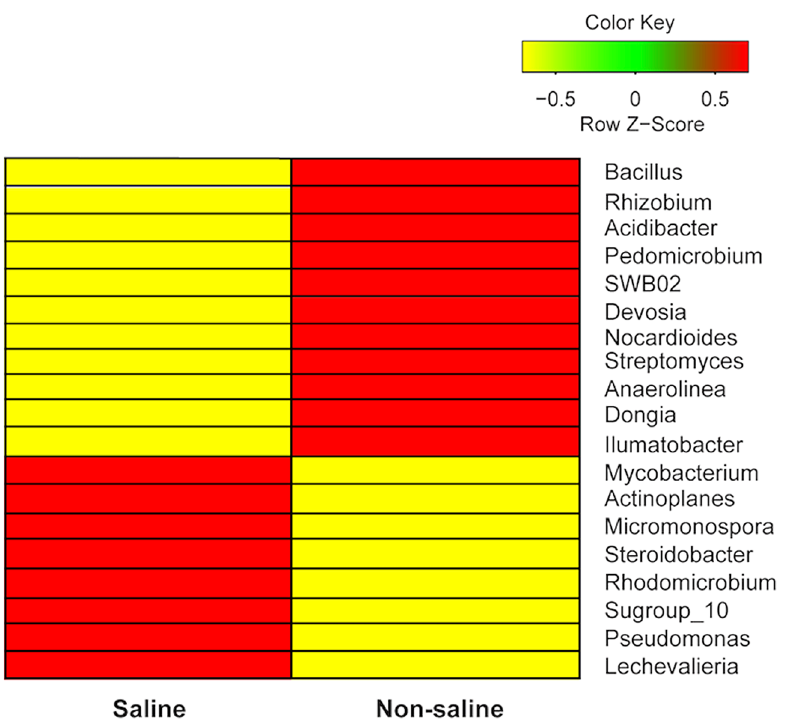
Figure 6. Heat-plots for proportional abundances of date palm root-associated bacterial genera under non- saline freshwater and saline groundwater irrigation. The figure shows hierarchical clustering of significant OTUs ( P < 0.05) of date palm roots between irrigation sources (saline groundwater vs non-saline freshwater). The legend with colour key indicates median-centered Z-scores, which were calculated after normalizing relative abundance values of selected